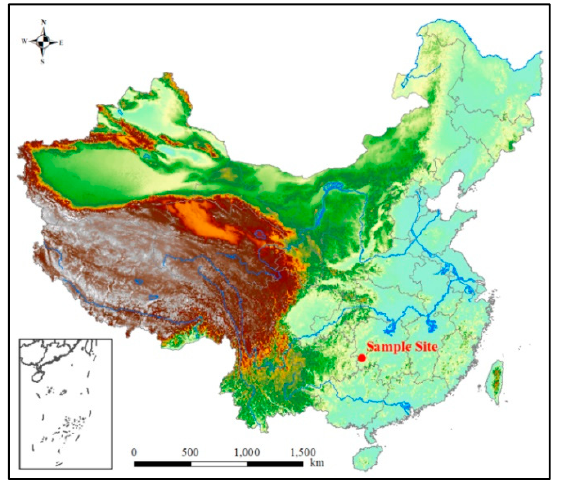
Figure 1. Location of study area in Hunan Province, southern China.